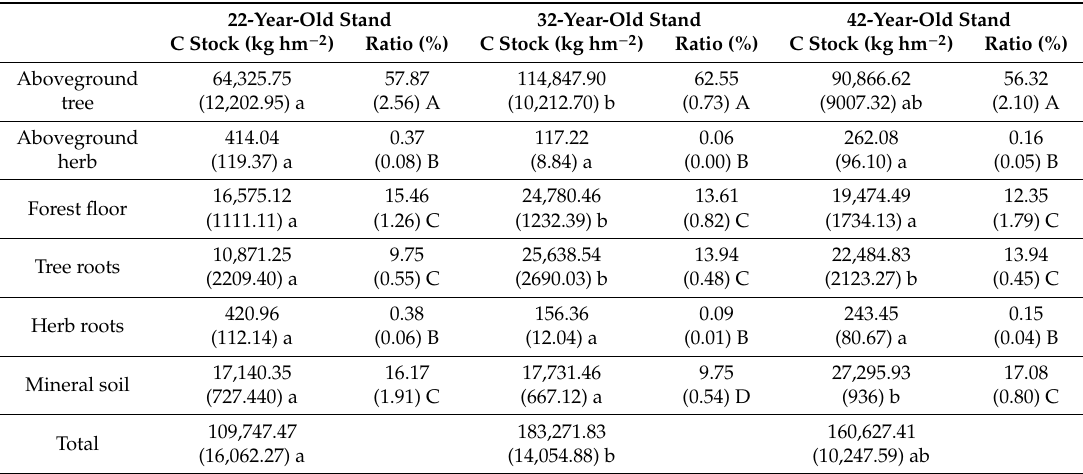
Table 5. The C Stocks of di ff erent components and their contributions to the total ecosystem C pool in three di ff erent aged stands.